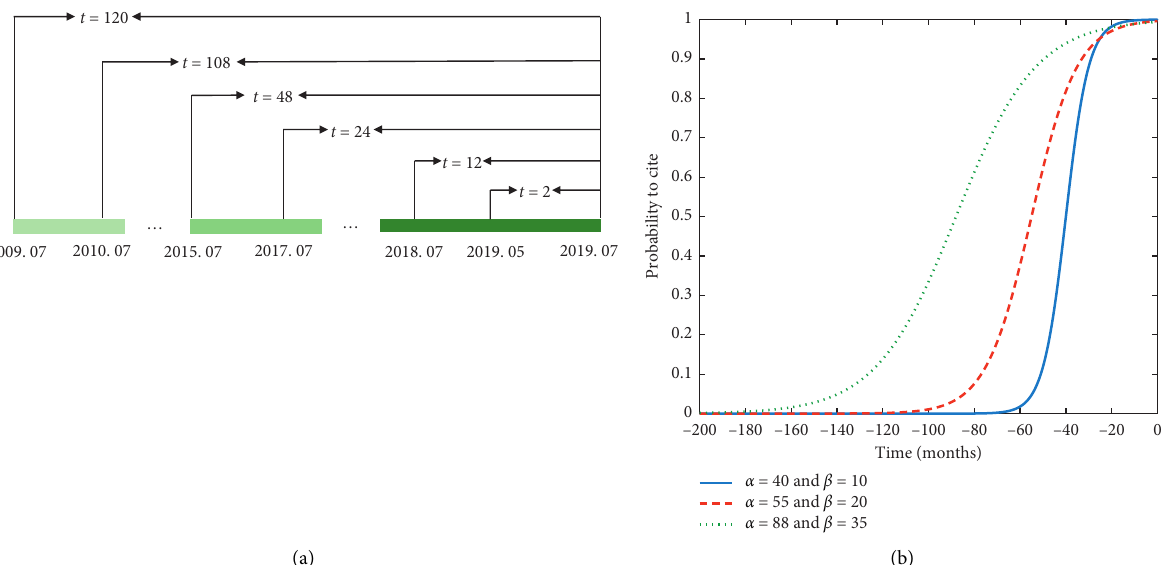
Figure 4: Relation between paper age ( t ) and weight factor to probability of a paper to be cited. (a) Sketch of paper age ( t ). (b) f ( t ) � ( 1/2 ) tanh ( t + α / β ) + ( 1/2 ) . g (3) < g (7) < g (14) < g (19)